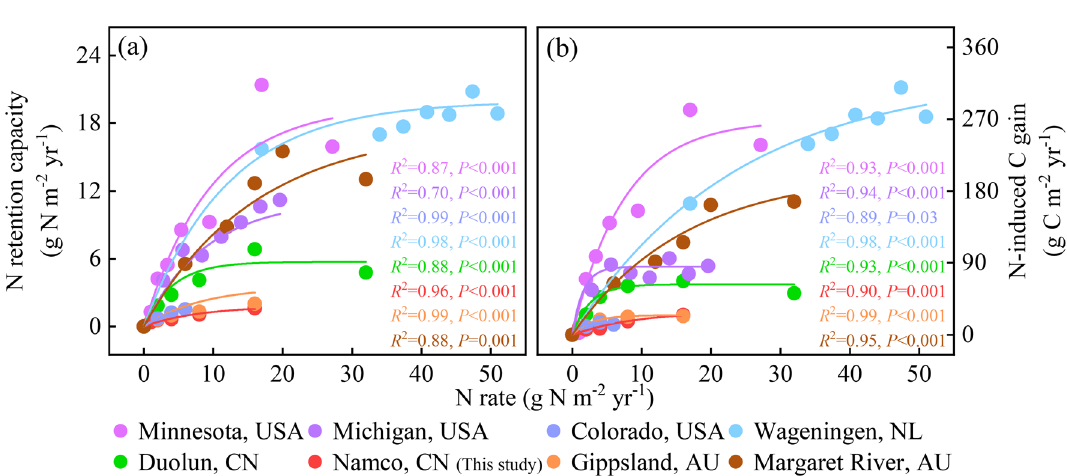
Figure 5. Eight examples showing the response of ( a ) N retention capacity and ( b ) N-induced C gain to N addition rate. USA, America; NL, Netherlands; CN, China; AU, Australia. Each colored line indicates the regression line fitted with the exponential function. Full regression results are shown in Appendix S2: Table